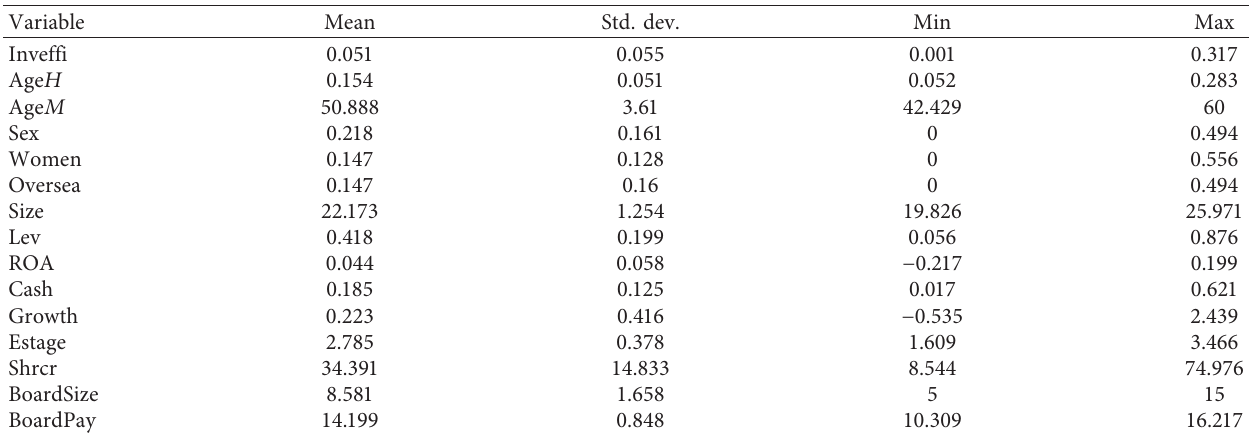
Table 3: Descriptive statistics of model 2.